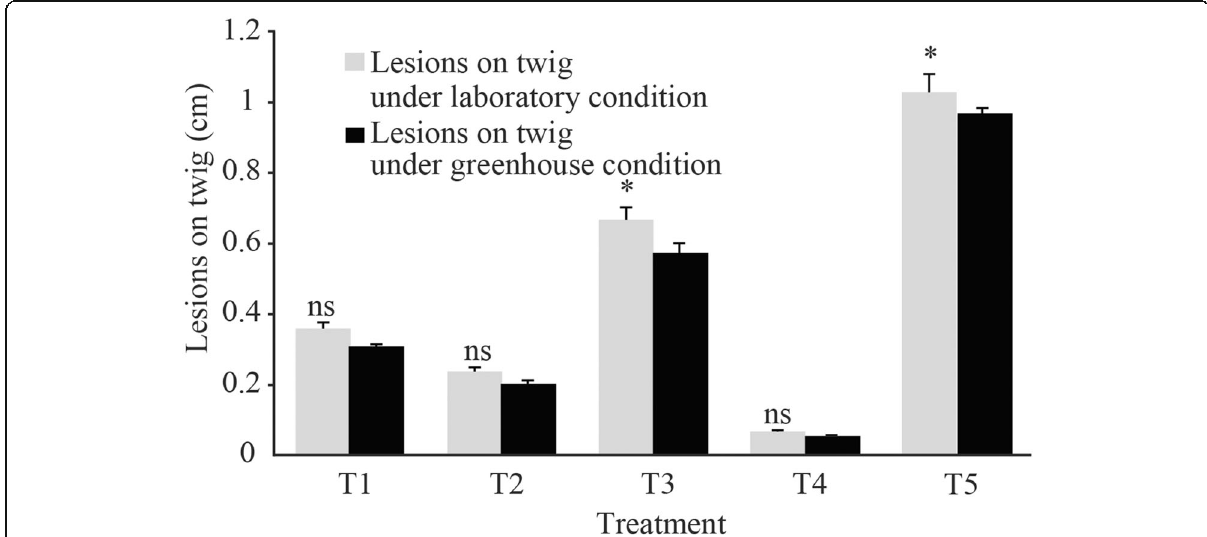
Fig. 4 Effect of environmental conditions to the antagonistic ability of EI-15 against stem end rot disease caused by Alternaria alternata on the twigs. Values are means ± SD ( n = 10). “ ns ” indicates not significant ( p > 0.05), whereas the asterisk indicates a significant difference ( p < 0.05) in the size of lesion present between treatments (paired t